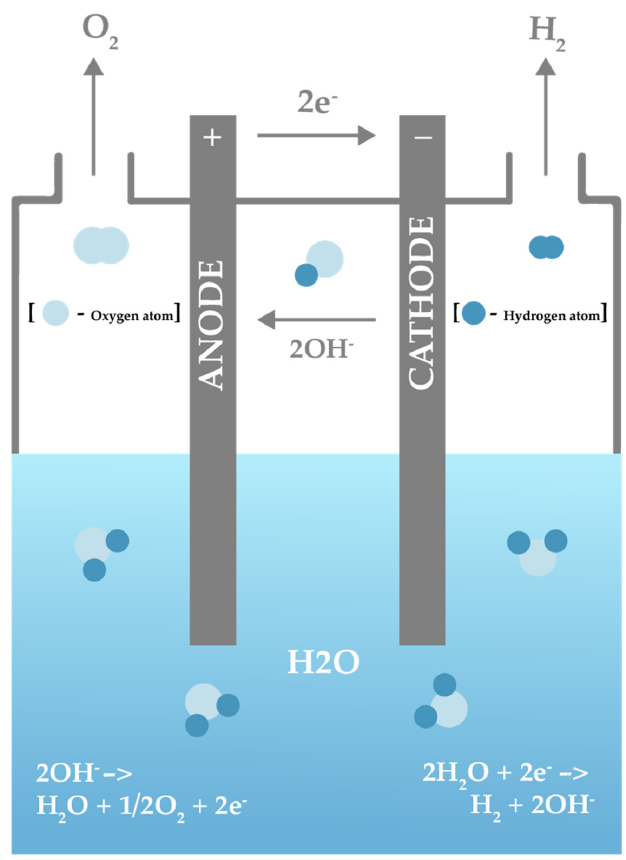
Figure 7. Electrolysis reaction. Hydrogen energy is being considered to have the potential to play a signi fi cant role in the transition to a cleaner and more sustainable energy system on a global scale. As renewable energy sources become more widespread, the production of green hydrogen will increase, helping to reduce our reliance on fossil fuels and decrease greenhouse gas emissions. Currently, worldwide energy organisations are focusing to reduce the costs of producing hydrogen and improving the e ffi ciency of existing systems [139]. An example of one such organisation is IRENA [140]. On the fl ip side, in 2021, several academists and professors started highlighting the hydrogen economy to be a scam hosted by fossil fuel industries to delay the current green energy transition [141–144]. This theory is proposed based on the facts built on the practical e ffi ciencies and costs of incorporating hydrogen systems into the energy transition. Nevertheless, positive inventions are emerging to tackle the issues backing this theory and the practical possibility of a hydrogen ecosystem in the future will only reveal itself over time. ITM Power PLC, Linde PLC, Engie SA, Air Liquide SA, and The Messer Group GmbH are some of the largest industrial producers of hydrogen around the globe. 4.2. Syngas Syngas, also called synthesis gas, is a mixture of carbon monoxide (CO), H 2 , and CO 2 gases that can be used as a fuel or as a feedstock for producing chemicals and other syn- thetic fuels. Syngas is typically produced through a several-step process with their feed- stock being carbon-containing materials, such as coal or biomass [145]. It is produced through gasi fi cation of heavy hydrocarbons and steam reforming or partial oxidation of